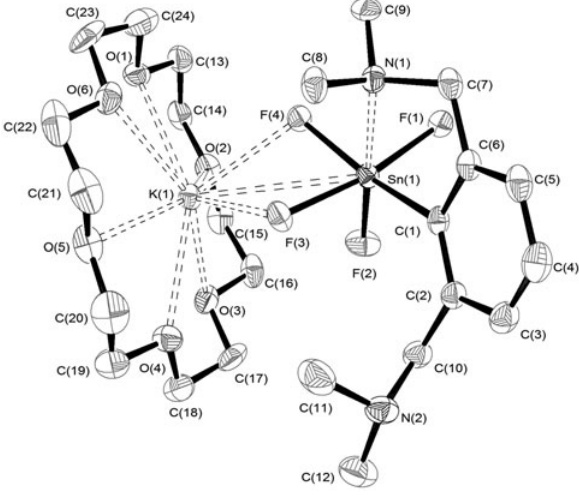
Figure 1 ORTEP representation at 30 % probability and atom numbering scheme of the isomer ( R )-[K(18-crown-6)] + [{2,6- NCH ) C H }SnF ] – . Hydrogen atoms have been omitted for (Me 2 2 2 6 3 4